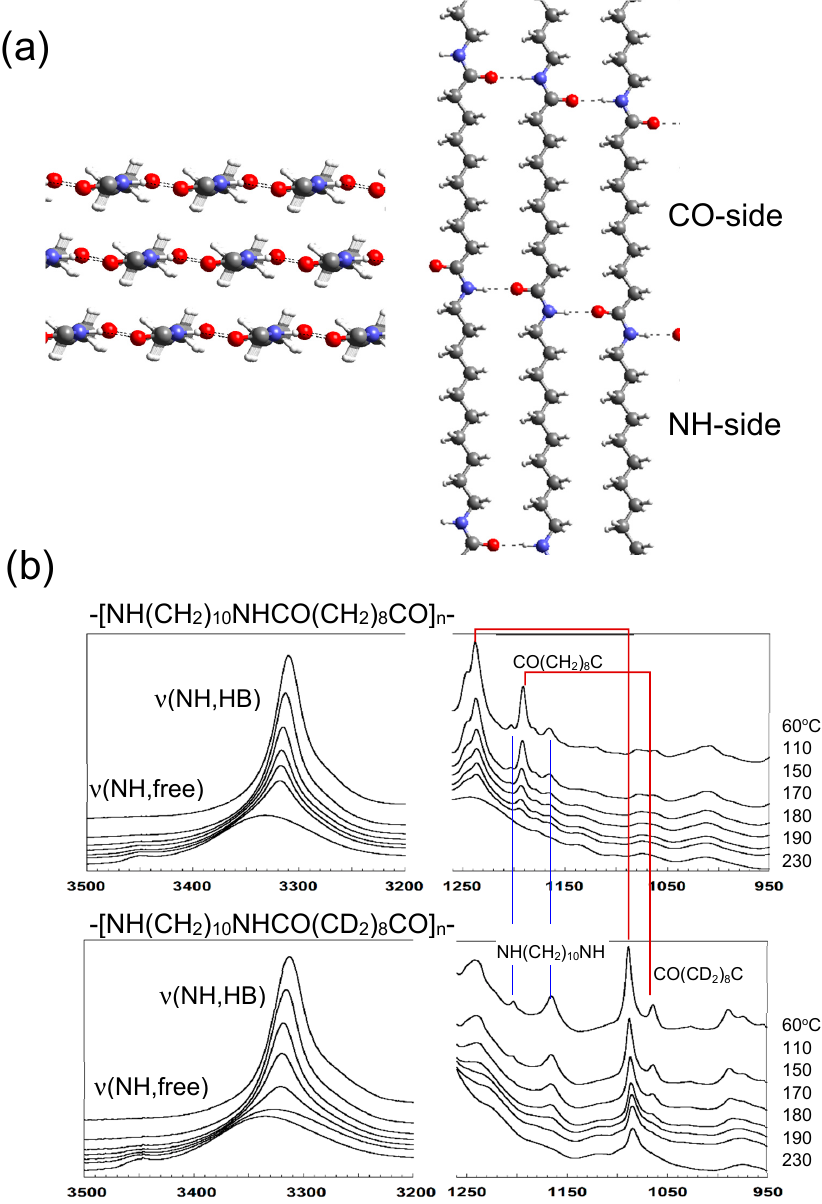
Figure 12. ( a ) Crystal structure of Nylon 1010. ( b ) Temperature dependence of IR spectra of nylon 1010 with normal methylene sequences and with the deuterated methylene sequences in the CO side. The band position was seen to shift toward the lower frequency side by the deuteration.